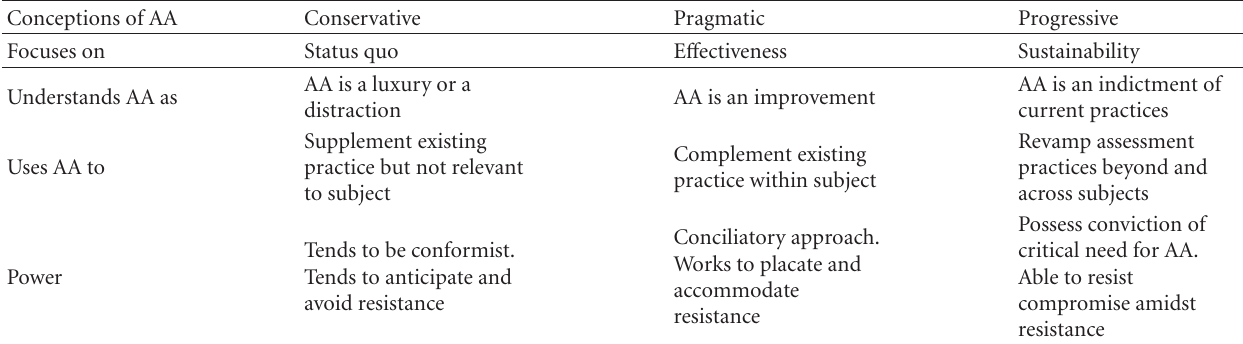
Table 1: 3 Di ff erent ways of experiencing